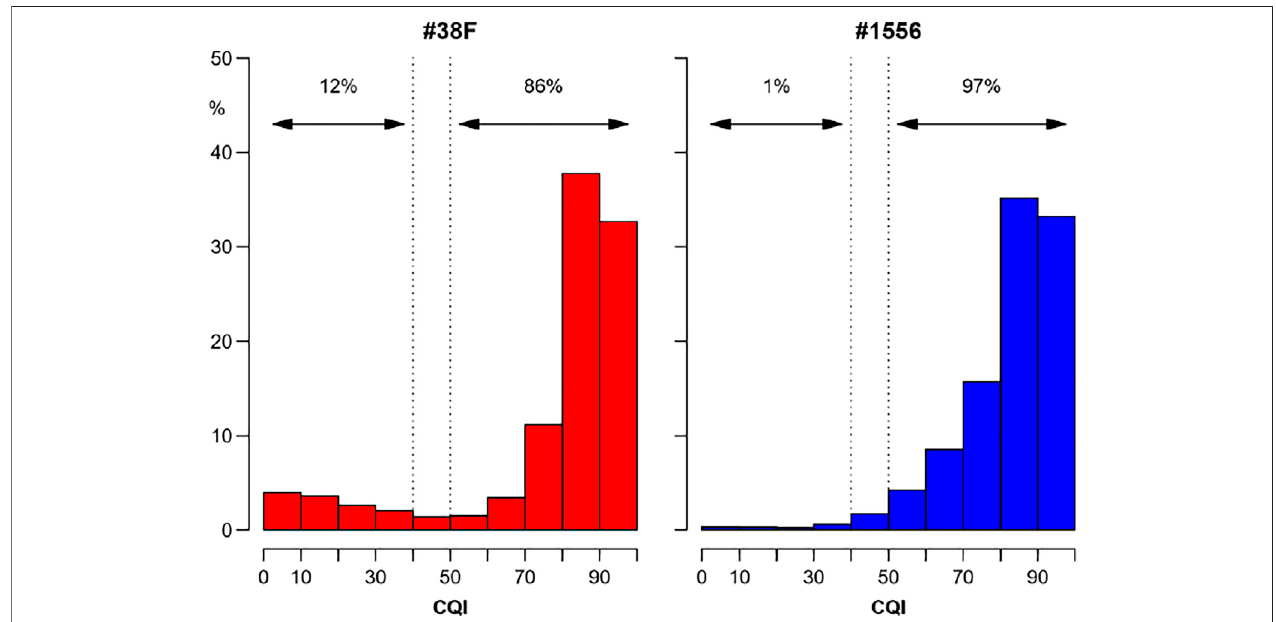
FIGURE 10 | Overall quality of very long-term ECG recordings from the distribution of running CQI values. Distributions (relative frequencies) of CQIs calculated second-by-second on ECG Holters recorded for 7 consecutive days continuously with a wearable device (RootiRx ® , Rooti Labs Ltd., Taipei, Taiwan) at 250 Hz in two subjects. The recording of the subject on the right (#1556) is almost completely analysable having good quality (CQI > 50%) for 97% of the time; by contrast, assessing heart rate variability in the recording on the left (#38F) might be problematic for a not negligible fraction of the time, being the quality “ very low ” or “ unacceptable ” (CQI ≤ 40%) for 12% of the